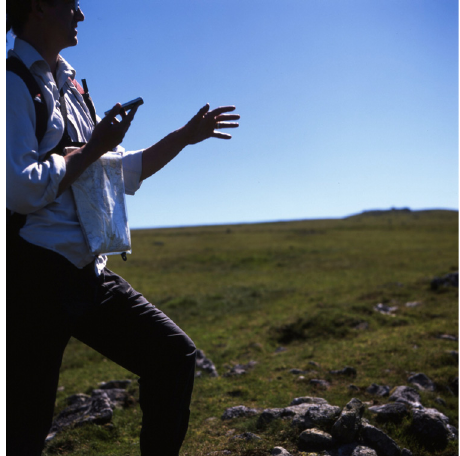
Fig. 1: Stuart Eve in ‘The Modern Phenom- enologist’ by Guy